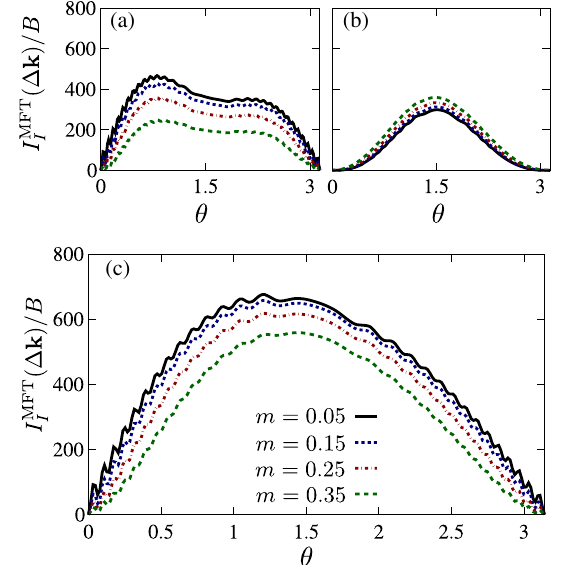
FIG. 11. Angular distribution of the inelastically scattered light intensity for different values of the interaction strength U at T ¼ 0 along the direction ϕ ¼ π = 4 . The calculations are based on MFT. Here, the number of sites is 40 × 40 . The ratio between the wave number of the probe light to the effective wave number of the optical lattice light κ ¼ 1 . 05 [Eq. (59)]. The lattice height is s ¼ 25 . Intensity contributions from (a) the density and longi- tudinal spin components, (b) the transverse spin component, and (c) total scattered light intensity. The scattered intensity decreases with increasing magnetization because of the changes in the density and longitudinal spin